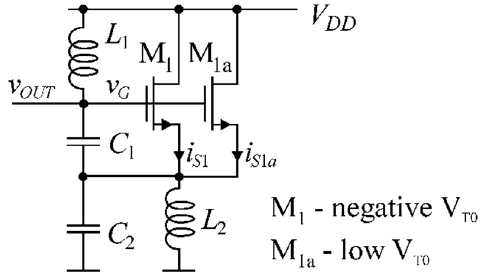
Figure 5. Improved version of HSCO.